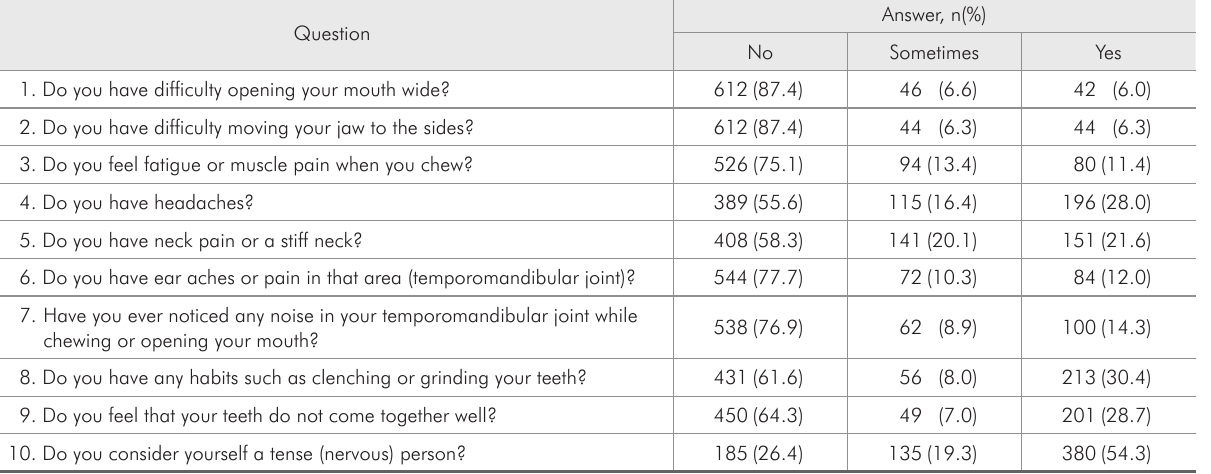
Figure 1 - Confirmatory Factor Analysis of Fonseca’s